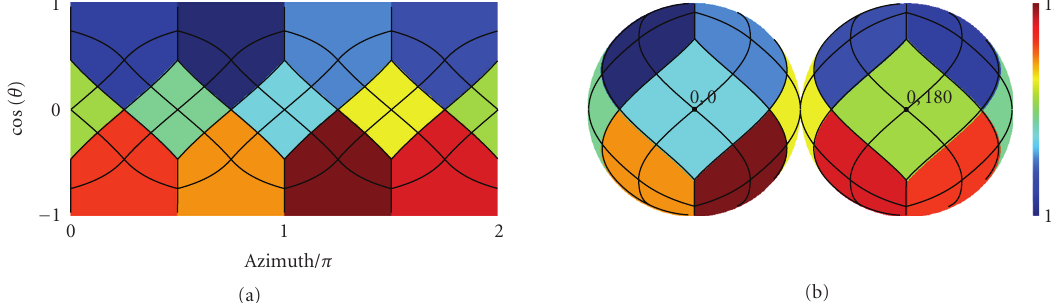
Figure 1: The 12 HEALPix base pixels color coded for the “ring” scheme. Overplotted the pixel boundaries for k = 1 which gives 48 pixels.